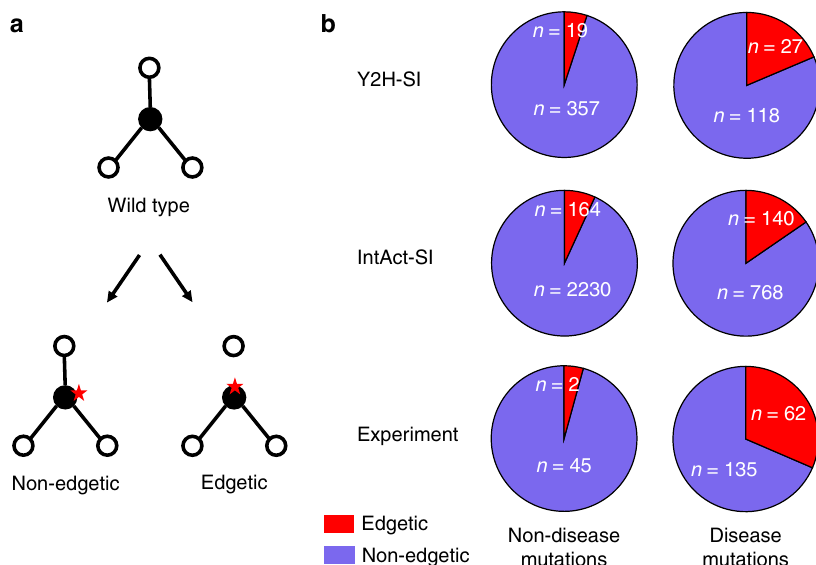
Fig. 2 Mutation edgotypes determined by geometry-based predictions and experiments. a Graphical illustration of edgetic and non-edgetic mutations. b Fraction of edgetic mutations among common non-disease mutations (left) and among Mendelian disease-causing mutations (right), determined by geometry-based prediction of mutation edgotypes in the two human structural interactomes, Y2H-SI and IntAct-SI, and by experiments 8 . Red slices represent edgetic mutations, and purple slices represent non-edgetic mutations. Source data are provided as a Supplementary Data fi le